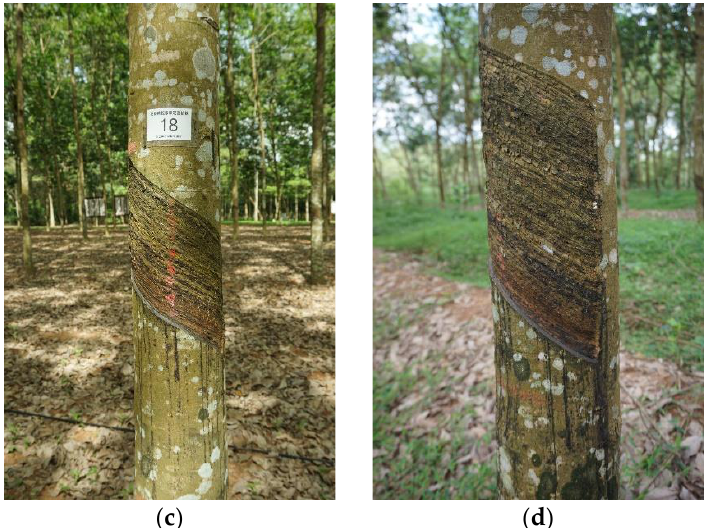
Figure 1. The original images of natural rubber tapping trajectory. ( a ) Pre-tapping, ( b ) One-year tapping age, ( c ) Three-year tapping age, ( d ) Five-year tapping age.